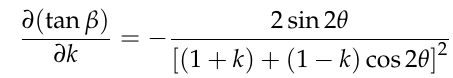
Figure 11. The β vs. in-situ stress ratio and dip angle ( φ m =31°).